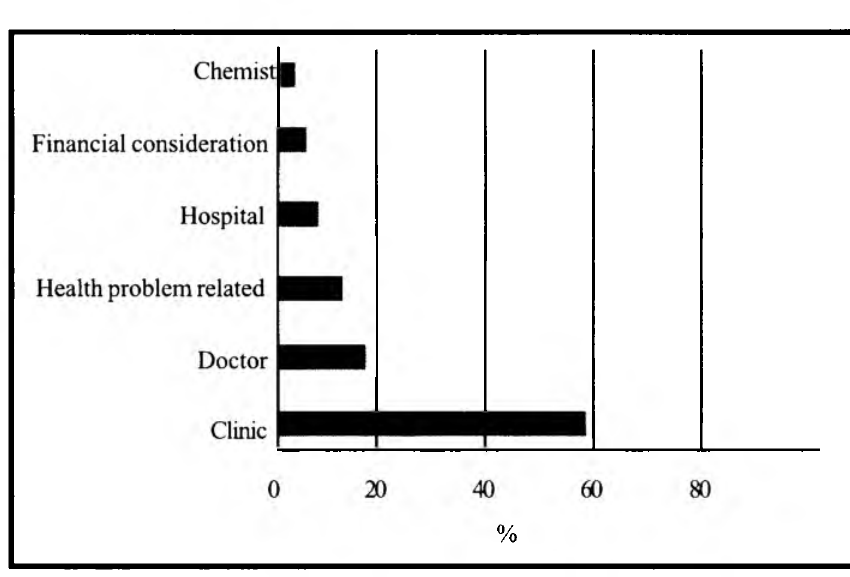
Figure 3: Help seeking preferences for health related